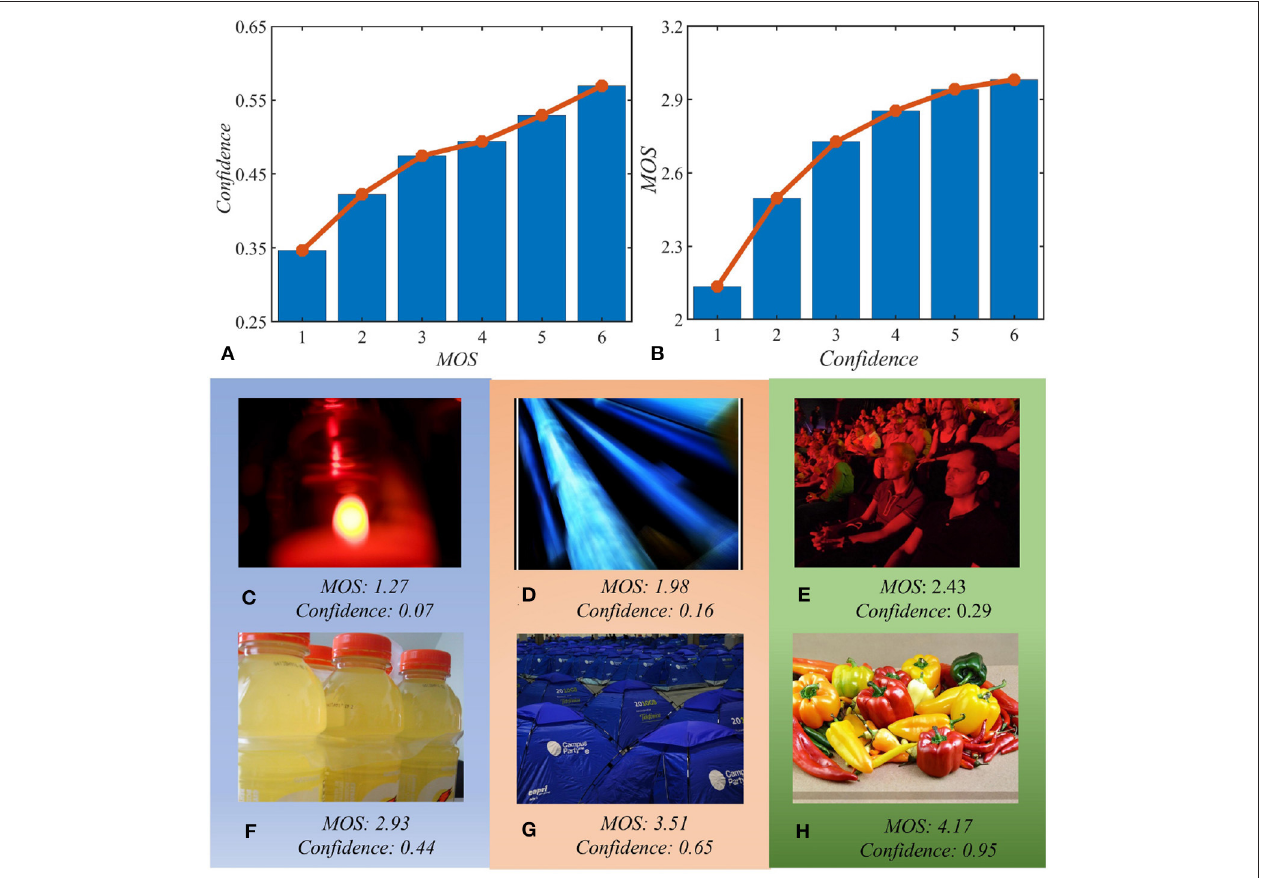
FIGURE 2 | Relation between recognition confidence and image quality. (A) Image quality affects recognition confidence; (B) recognition confidence indicates image quality; (C–H) representative images with different prediction confidence and mean opinion score (MOS). Panels (C–H) correspond to six ascending bins of B whose MOS increases with confidence. All results are obtained from the KonIQ-10k dataset based on EfficientNet-B0 network ( Tan and Le,